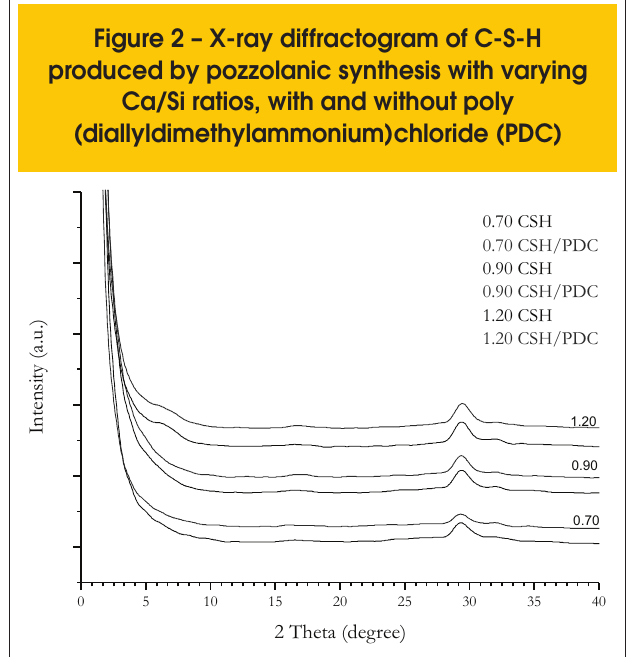
Figure 1 – X-ray diffraction diagram of synthesized tobermorite: plane [002] (14 Å) around 6.5° (2 θ ); plane [220] (3.06 Å) around the 30° (2 θ ); plane [200] (2.81 Å) around 32.5° (2 θ )